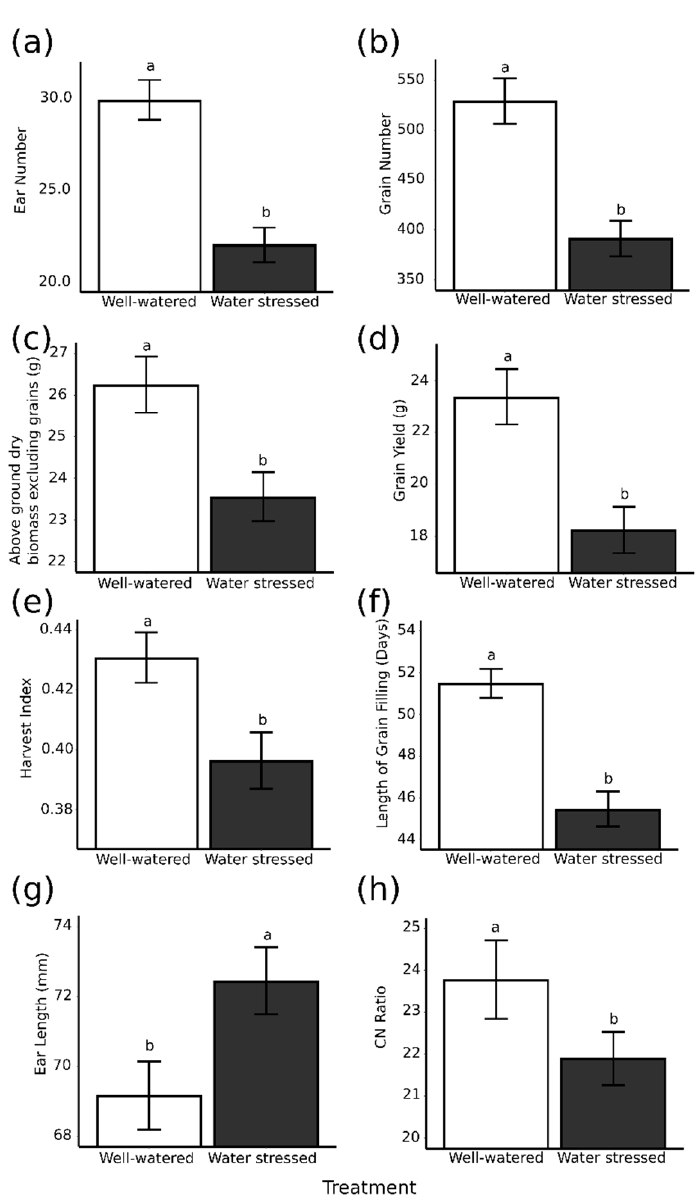
Figure 2. The significant effects of the well-watered (open bars) compared with water-stressed treatment (filled bars) on plant growth parameters: ( a ) ear number, ( b ) grain number, ( c ) above ground biomass excluding grains, ( d ) grain yield, ( e ) harvest index, ( f ) length of grain filling, ( g ) ear length and grain parameter ( h ) C:N ratio. Significant differences are indicated by different letters above bars ( p < 0.05). Error bars are the standard error of the means.